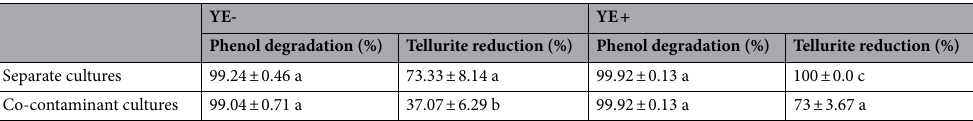
Table 1. The yield of phenol and tellurite removal in different cultures in 98 h. Values are mean (n = 3) ± SD. Different alphabets in phenol and tellurite columns represent significance at p < 0.05 after applying post hoc Tukey’s